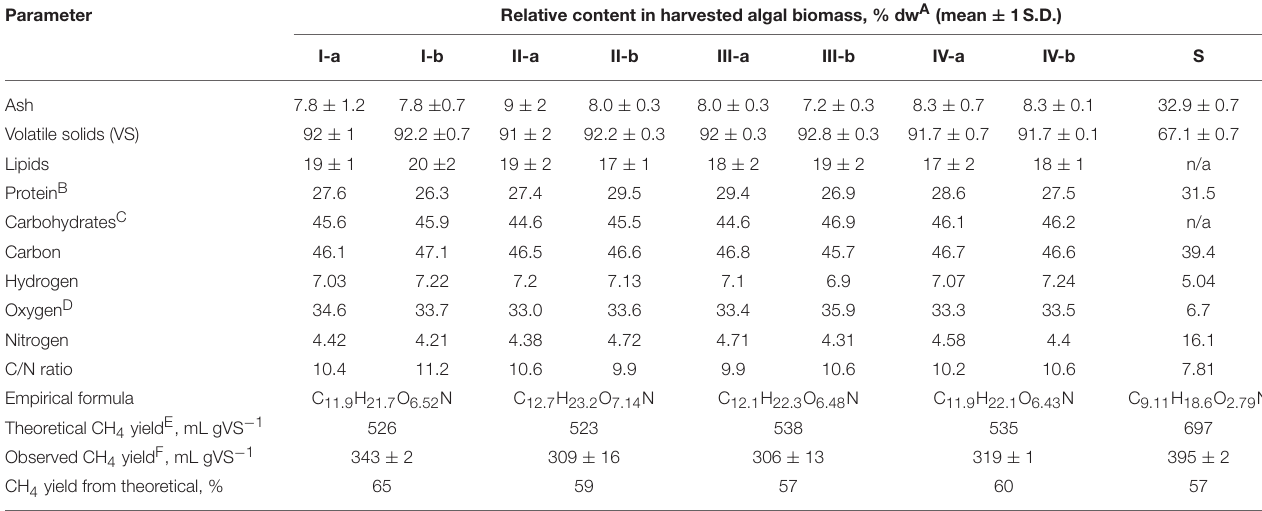
TABLE 1 | Biochemical composition of filamentous algal biomass (I-IV) and sewage sludge (S), and its effect on theoretical and observed ultimate methane yields from biomass as mono-substrates.